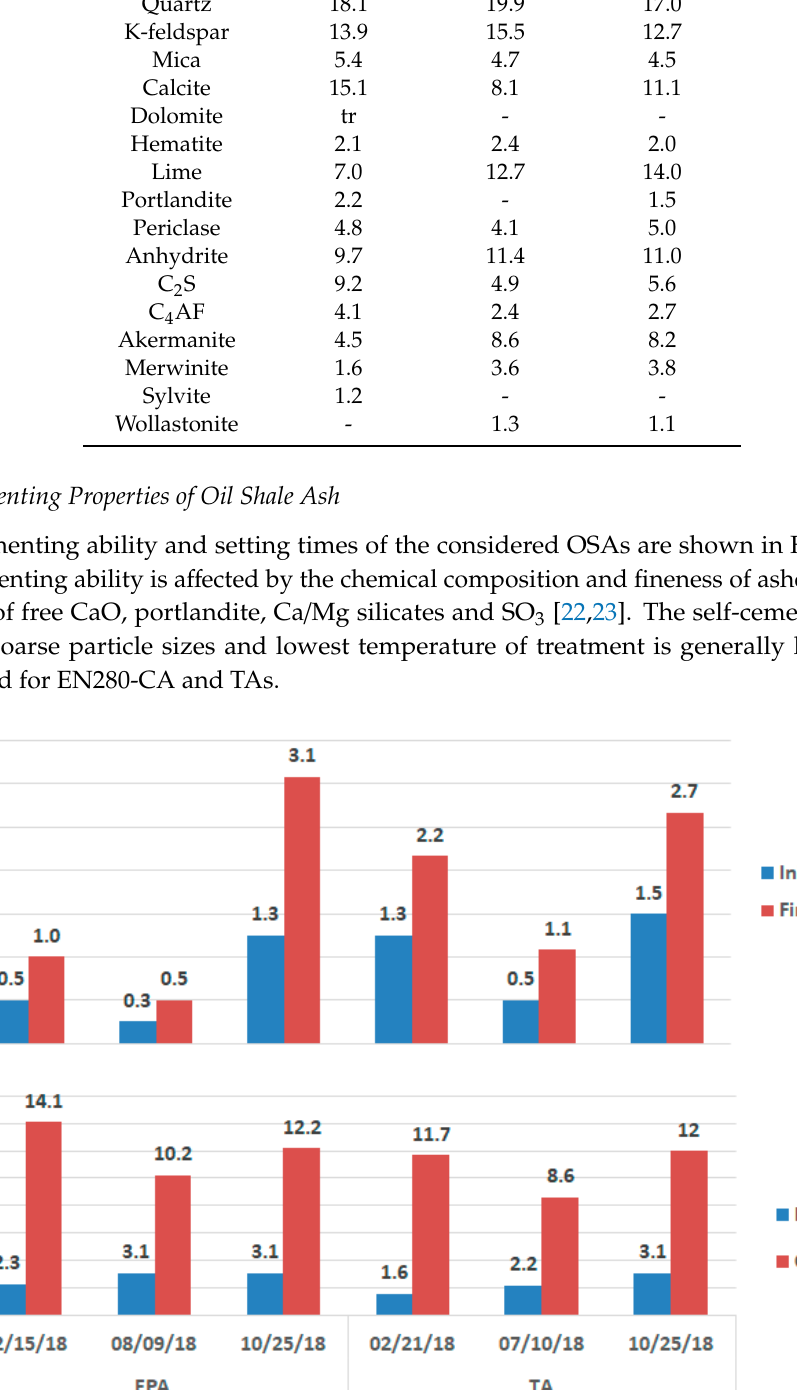
Figure 6. Setting times and self-cementitious ability for EPP (EPA, TA) and EN280 (TA, CA). Because of this reason, less reactive ashes (EN280) would require post-treatments like higher temperature treatment, grinding, sieving etc. in order to increase their performance. Due to insufficient amounts of reactive phases present the EN280 ash specimens fell apart during the curing of samples as cohesion is lost after evaporation of water in the 60% RH environment (Figure 7).